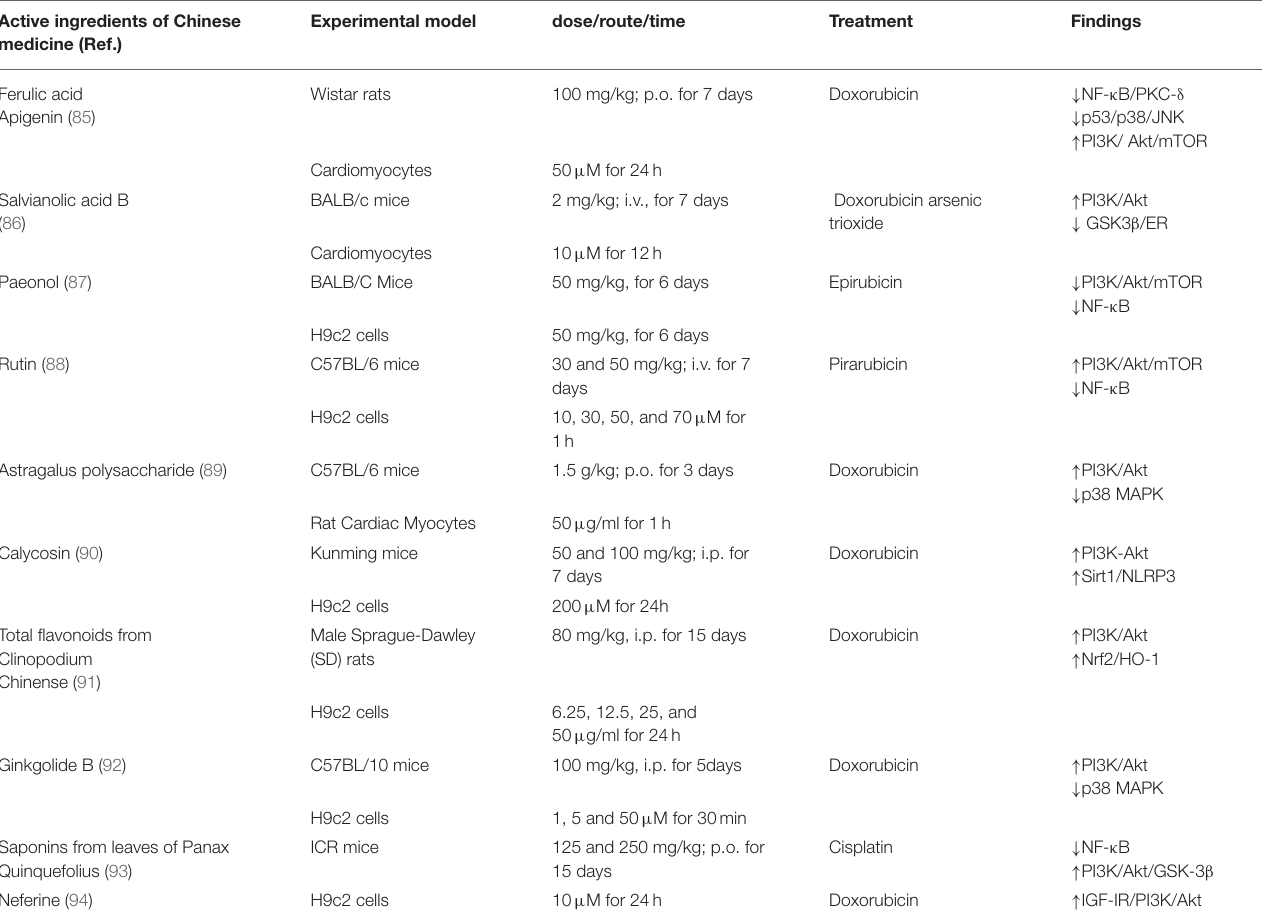
TABLE 3 | Active ingredients of Chinese medicine against cytotoxic drug–induced cardiotoxicity through regulation of the PI3K/Akt signaling pathway. Active ingredients of Chinese medicine